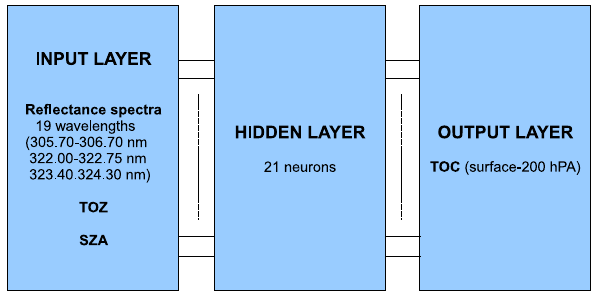
Fig. 2. General scheme, including topology, of the OMI-TOC NN algorithm.